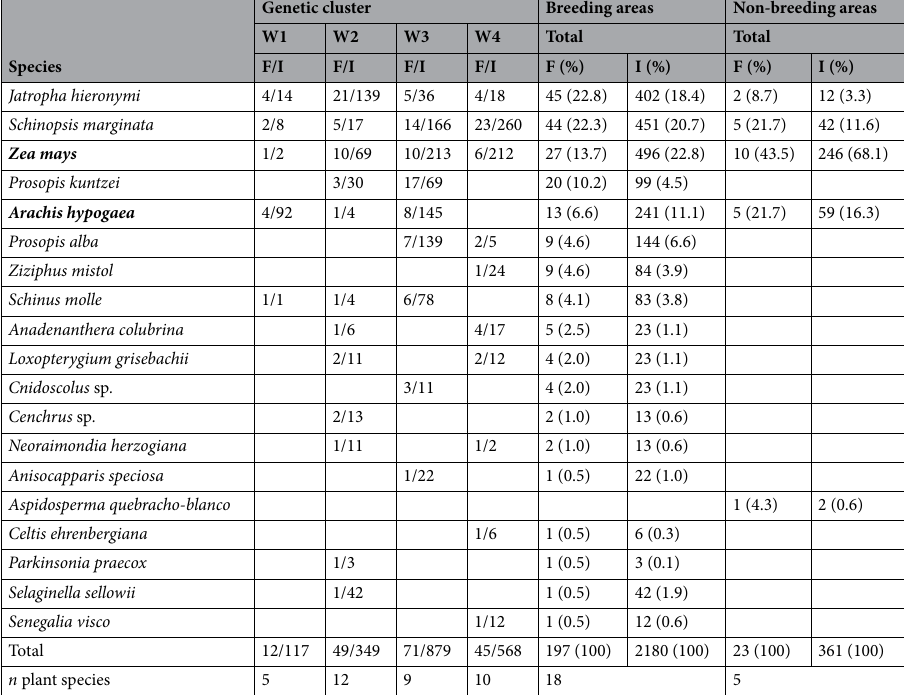
Table 6. Diet composition of the red-fronted macaw in each genetic cluster, and pooled breeding and non- breeding areas, according to flocks (F) and individuals (I). Cultivated species are shown in